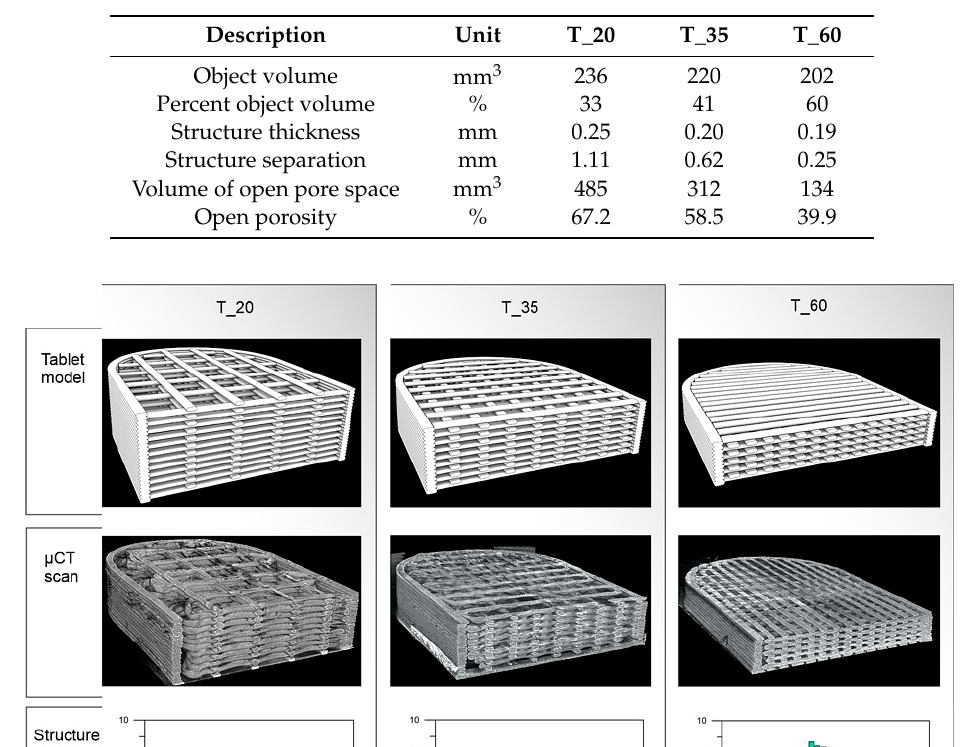
Table 5. Comparison of µ CT scan data of 3DP PVA_K / CL tablets with 20% (T_20), 35% (T_35), and 60% (T_60) infill ratio.